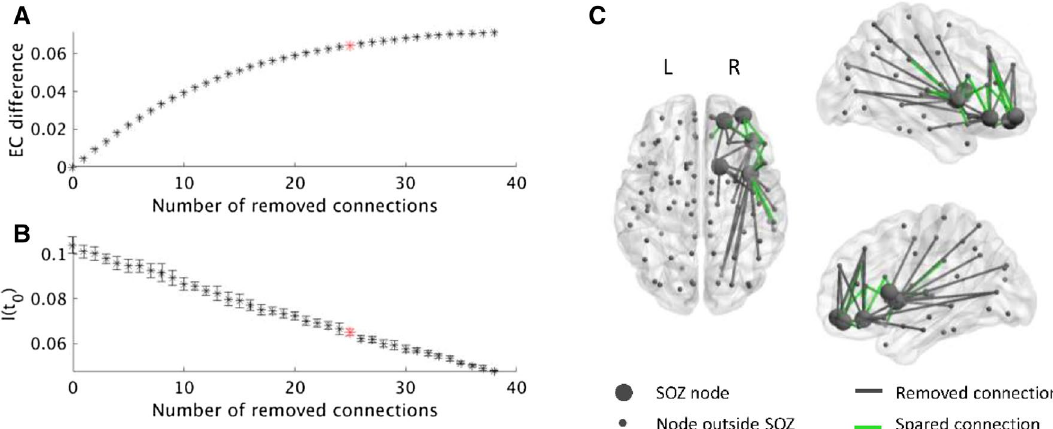
Figure 3. Example of selecting the connections to remove for patient 15. ( A ) The selection was found separately for each number of connections using simulated annealing and the EC difference. After the removal of some connections from the SOZ to the rest of the brain, the EC difference of the SOZ increased. Removing all connections as in the surgery resulted in the highest EC difference. However, a 10% smaller decrease in EC was achieved by removing only 25 of the 38 connections, thereby sparing 13 connections (red star). ( B ) We calculated the actual effect of each resection on the seizure propagation model by measuring I(t 0 ) after the resection took place. I(t 0 ) decreases in a roughly linear manner with the number of removed connections. The red star indicates the resection corresponding to a 90% decrease in EC difference. Errorbars indicate the Parts of the figure were visualized with the BrainNet Viewer toolbox (Xia et al. 2013) (http:// www. nitrc. org/ proje cts/